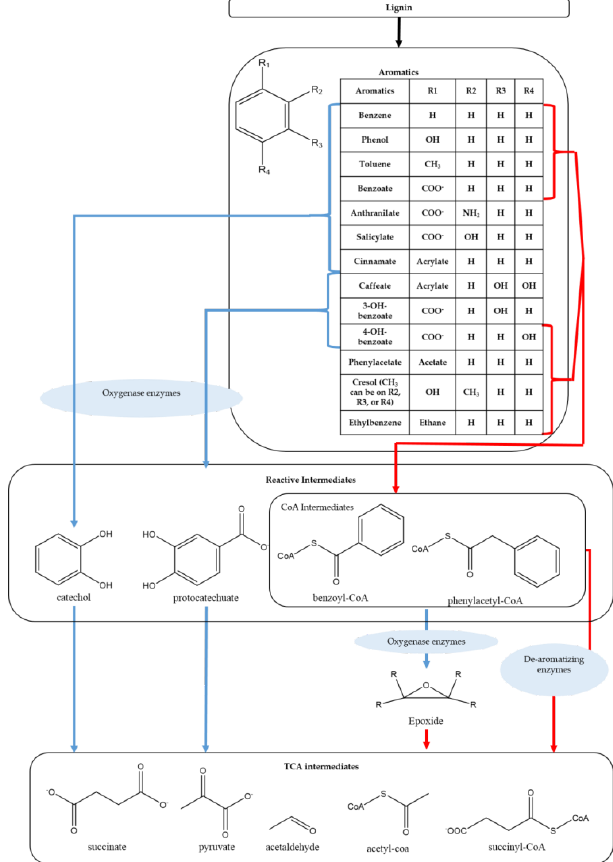
Figure 3. Aromatics can be degraded via aerobic routes (indicated by blue lines) or anaerobic routes (indicated by red lines). In the two far left routes, aromatics are converted to reactive